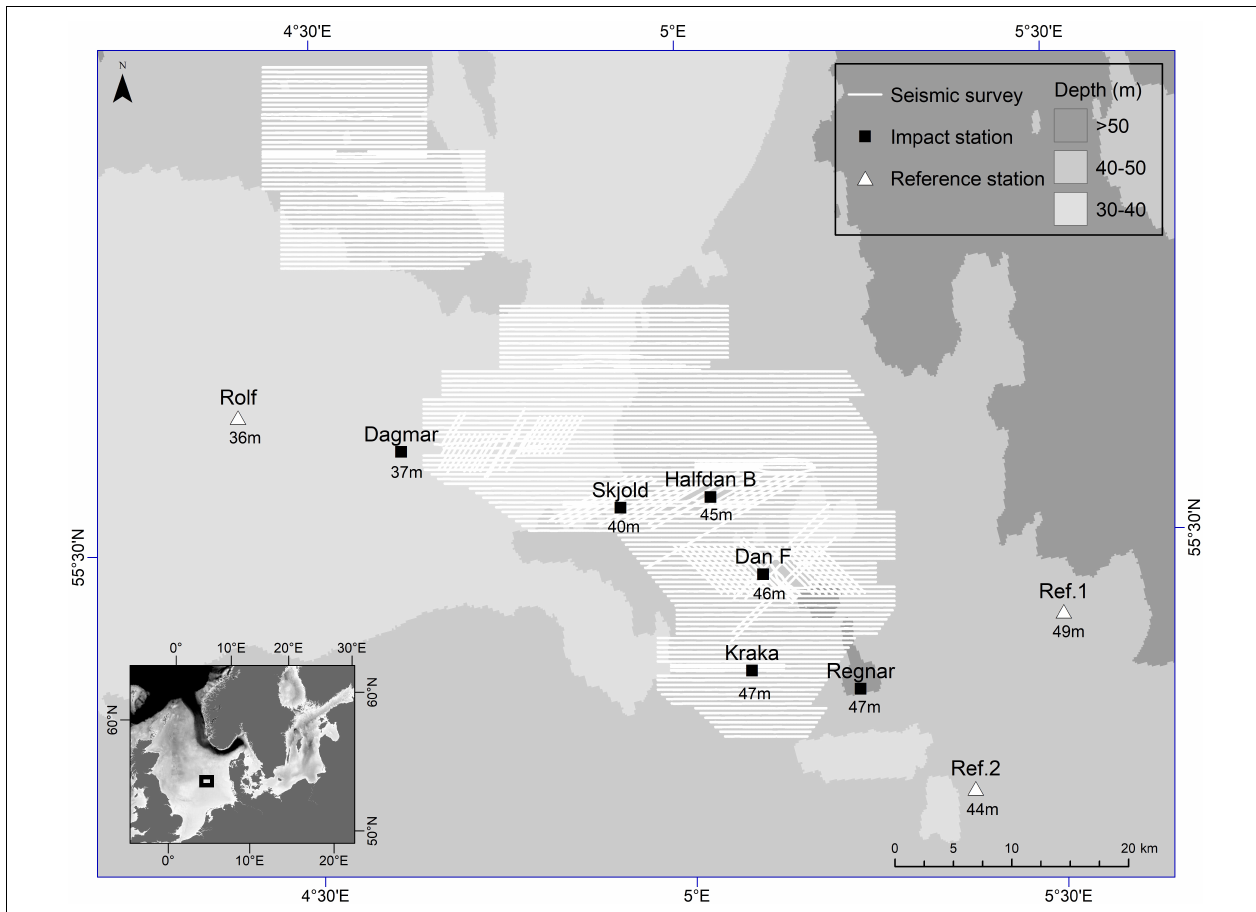
FIGURE 1 | Map of the study area in the Danish sector of the central North Sea (insert) with the seismic survey transect lines highlighted in white, and the nine recording stations, divided into impact stations (squares) and reference stations (triangles). C-PODs were deployed at all nine stations and six full band acoustic recorders were placed at Rolf, Dagmar, DanF, Kraka, Regnar and Ref.1. Numbers indicate water depth at each deployment site (m). Projection UTM zone 31N, ED50. Source: Total E&P Denmark